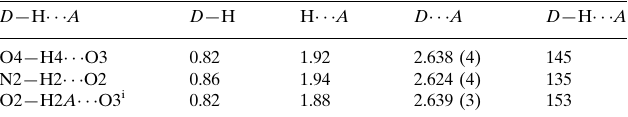
Hydrogen-bond geometry (A˚ , (cid:4)